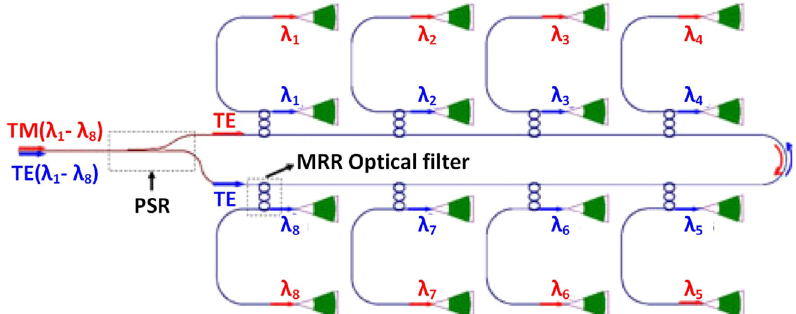
Figure 14: Schematic of a 16-channel hybrid WDM-PDM (de)multiplexer